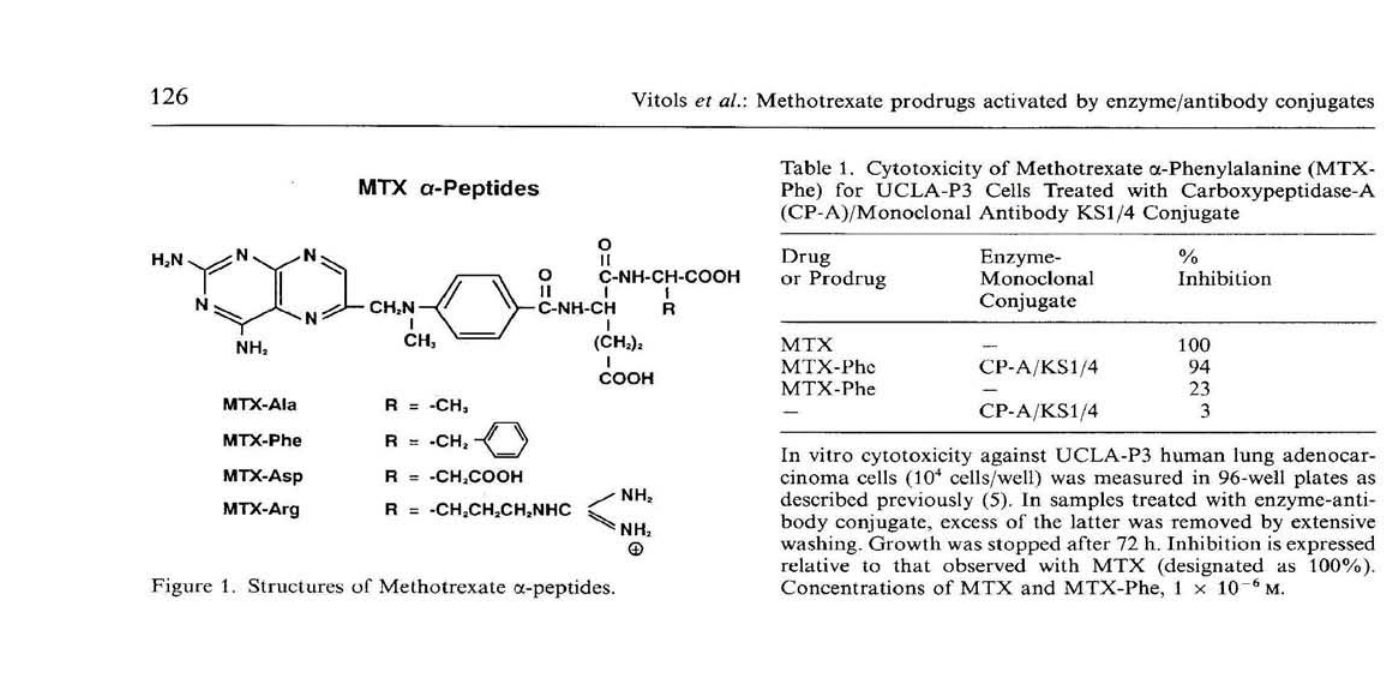
Figure 1. Structures of Methotrexate α-peptides.